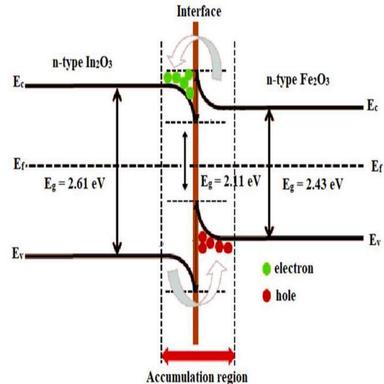
The assumed formation of heterojunction in In2O3/Fe2O3 nanocomposites.